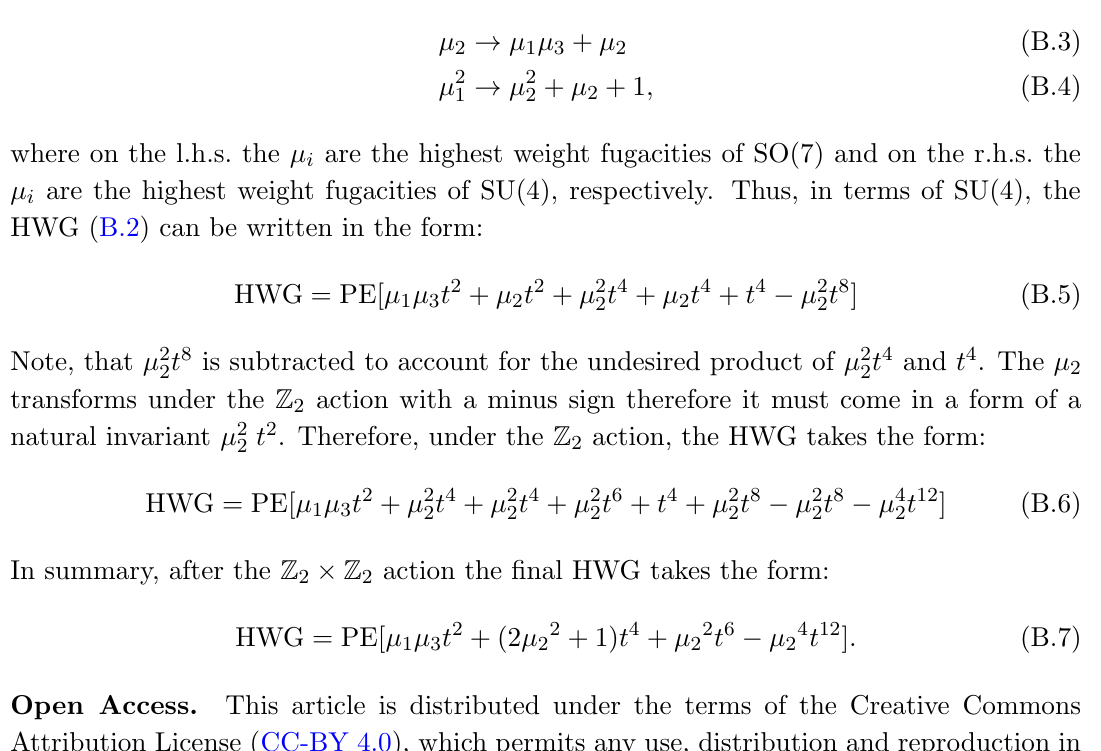
Figure 38 . Sp(1) gauge theory with D 4 global